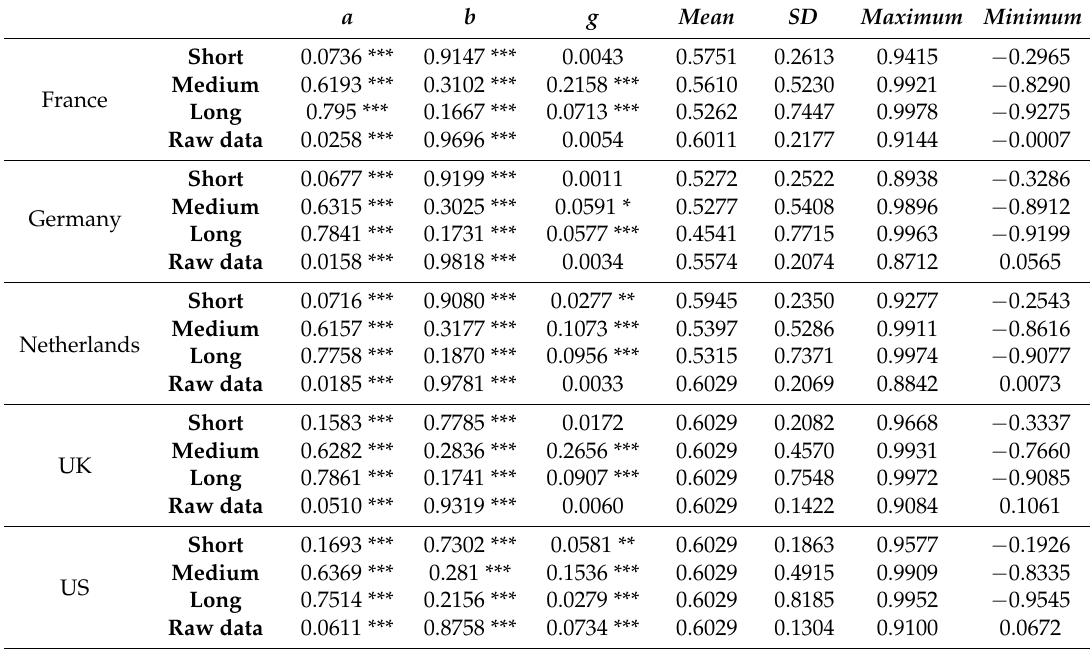
Table 6. Estimation results of the Asymmetric Dynamic Conditional Correlation (ADCC-GARCH) model for the full period and three levels of decomposition: securitized real estate and local stock market